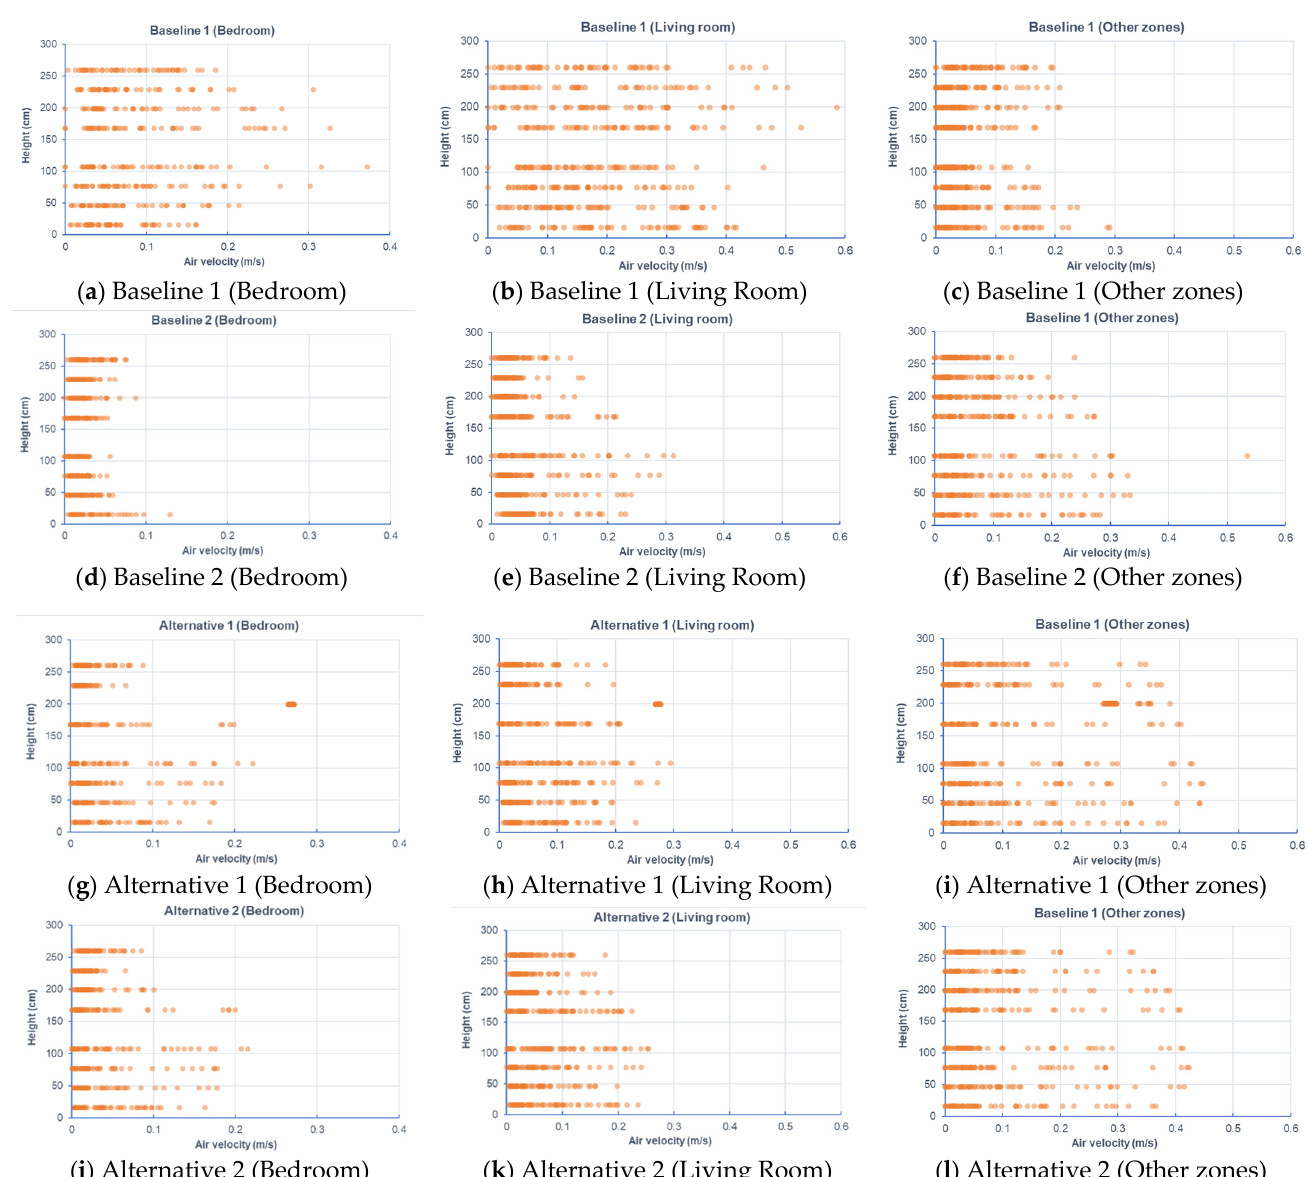
Figure 9. Air velocity for different rooms taken from different design options.